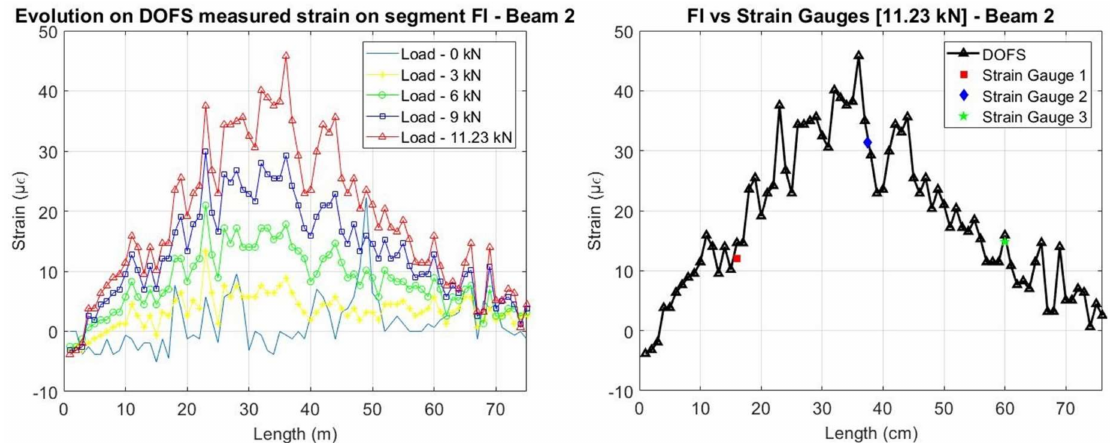
Figure 16. Strains measured by the DOFS on the embedded segment for Beam